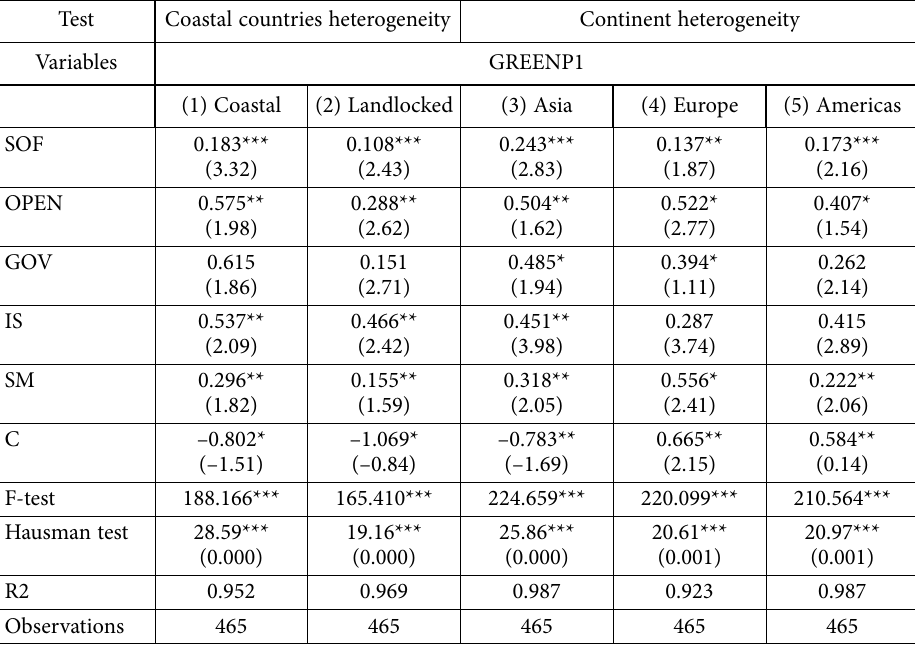
Table 6. Result of robustness